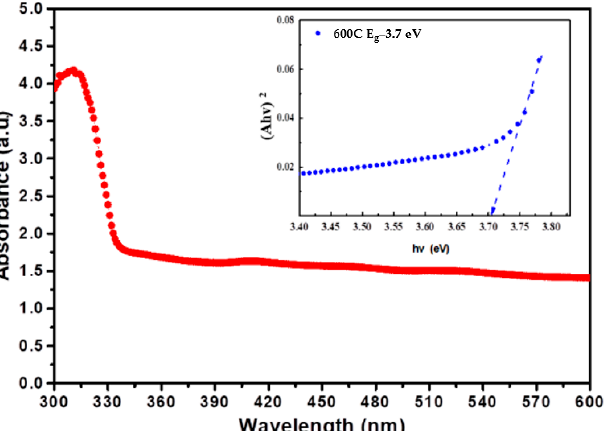
Figure 6. UV-Visible spectra and energy band gap of ZnO nanoparticles synthesized at a constant applied potential of 16 kV, a distance between collector and nozzle of 12 cm, a flow rate of 1 mL/h, and a calcination temperature of 600 ◦